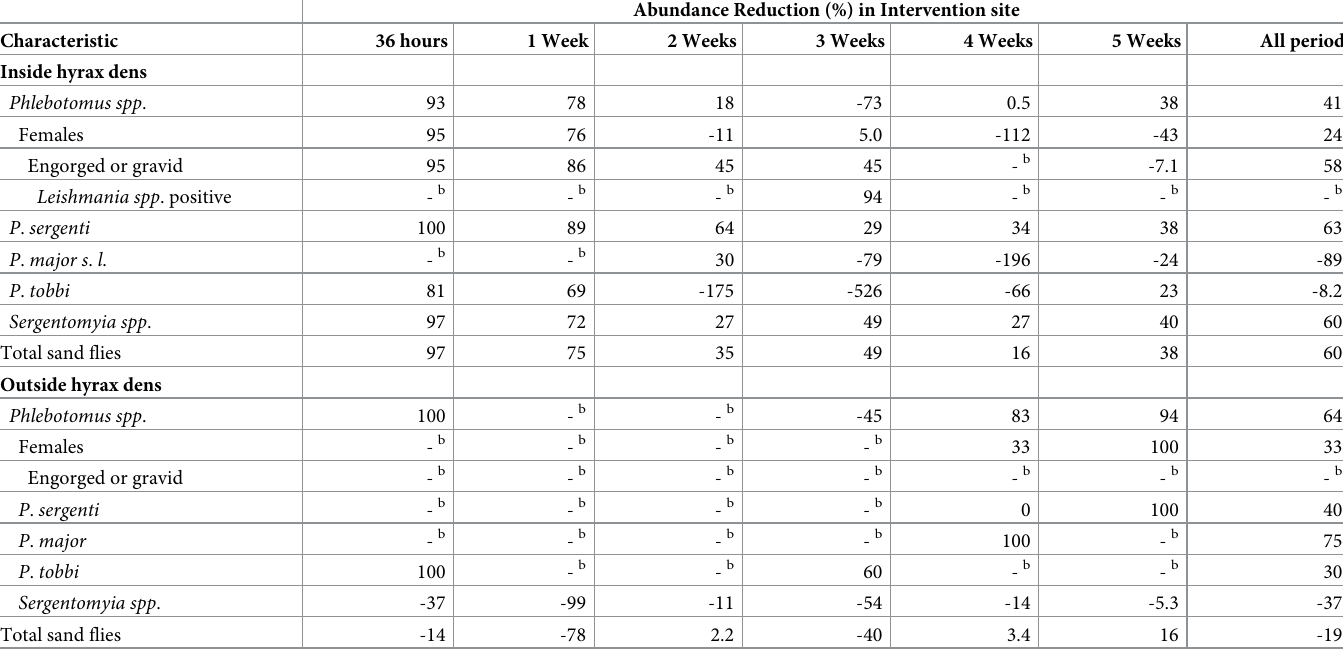
Table 4. Sand fly Abundance Reduction (%) a in the intervention site (Intervention site) during the post-intervention period by collection week, Tayasir, Palestine, July-September 2019.